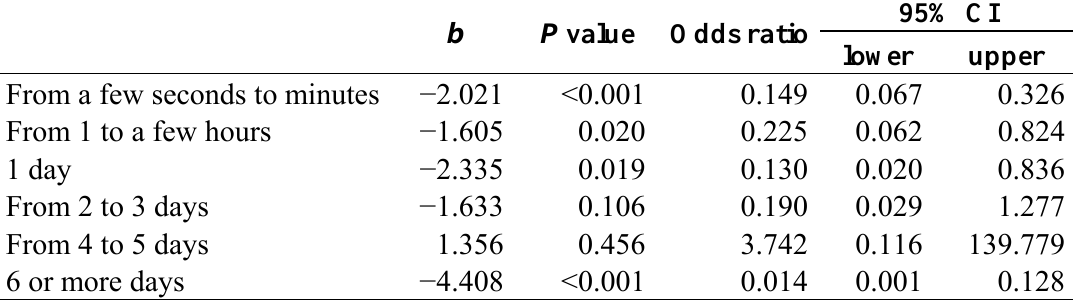
Table 3. Results of regression model to evaluate relationships between the epicentral distance and the presence of unusual behaviors of dogs during each time period; CI = confidence interval b =